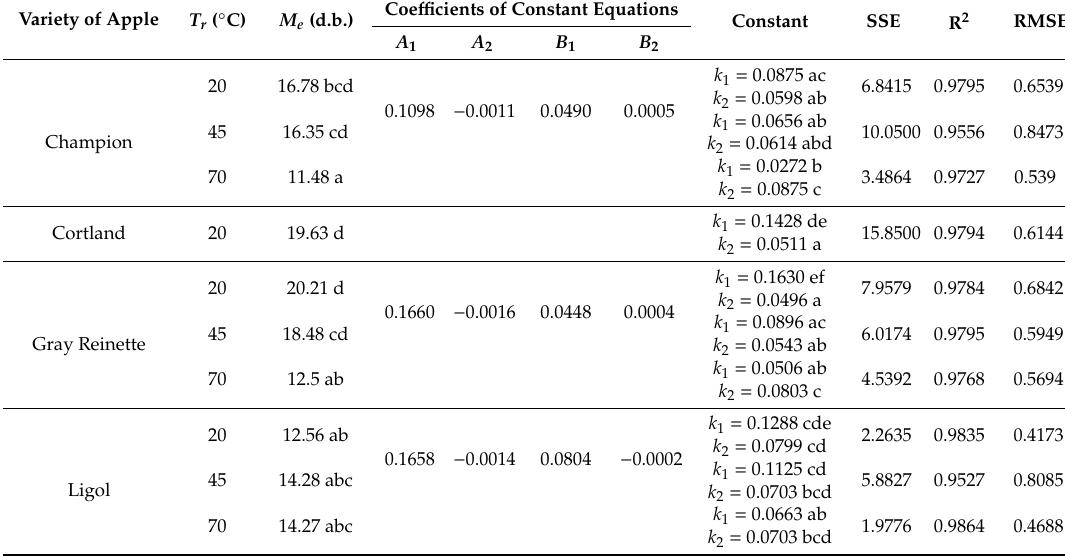
Table 5. Coe ffi cients of the constant equations for the Peleg model (Equations (1) and (2)) and results of statistical analyses on the rehydration modeling of di ff erent varieties of dried apples. Coe ffi cients of Constant Equations Variety of Apple T r ( ◦ C) M e (d.b.) Constant SSE R 2 RMSE A 1 A 2 B